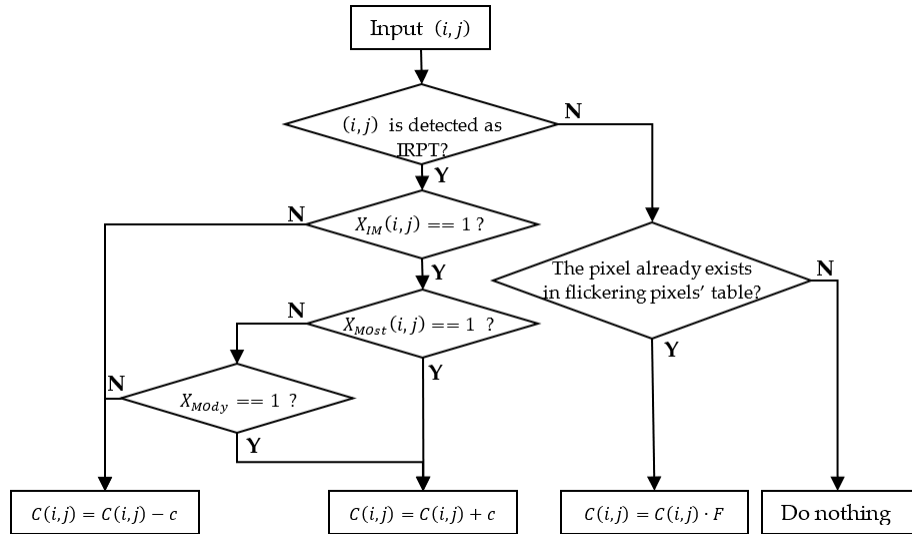
Figure 3. Confidence evaluation mechanism of flickering pixel.